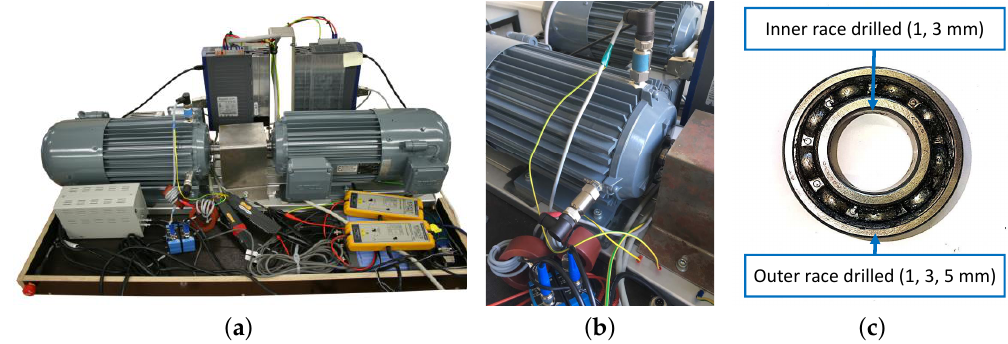
Figure 1. Test bench and bearings. ( a ) test bench (model: EMOD FKFIE2100LA, Pmech: 3 kW, nnom: 1440 /min, Vnom: 400 V, Inom: 6.4 A, cos φ : 0.78), ( b ) sensors mounted on the motor, ( c ) bearing with different faulty conditions.